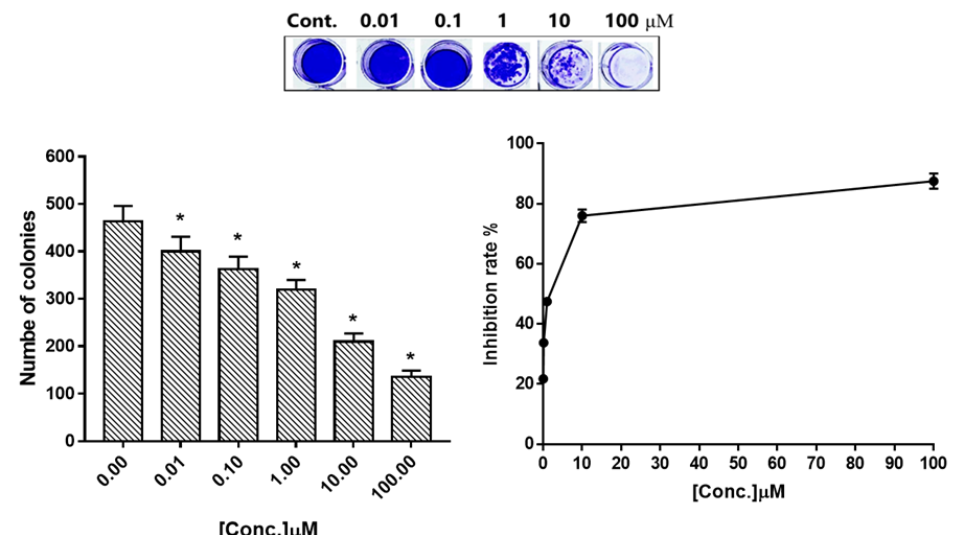
Figure 2. Representative images of colony numbers in control and treated HepG2 cells with different concentrations (0.01, 0.1, 1, 10, 100 μM) of compound 4 . Values are represented by mean ± SE ( n = 3 independent trials). * Significant difference between control and treated HepG2 cells with different concentrations using ANOVA ( p ≤ 0.05) using SPSS Version 22.